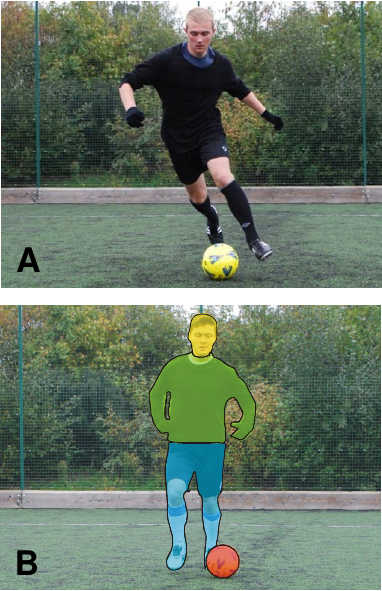
Figure 1. Two static images viewed by participants in the anticipation task, in which they were required to pre- dict the intended direction of the player (left/right). Im- age B depicts interest areas (head, upper body, legs and feet, ball); these were not visible to